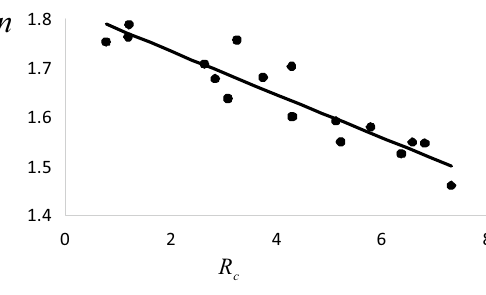
Fig. 3 Correlation diagram between R c and n of 17